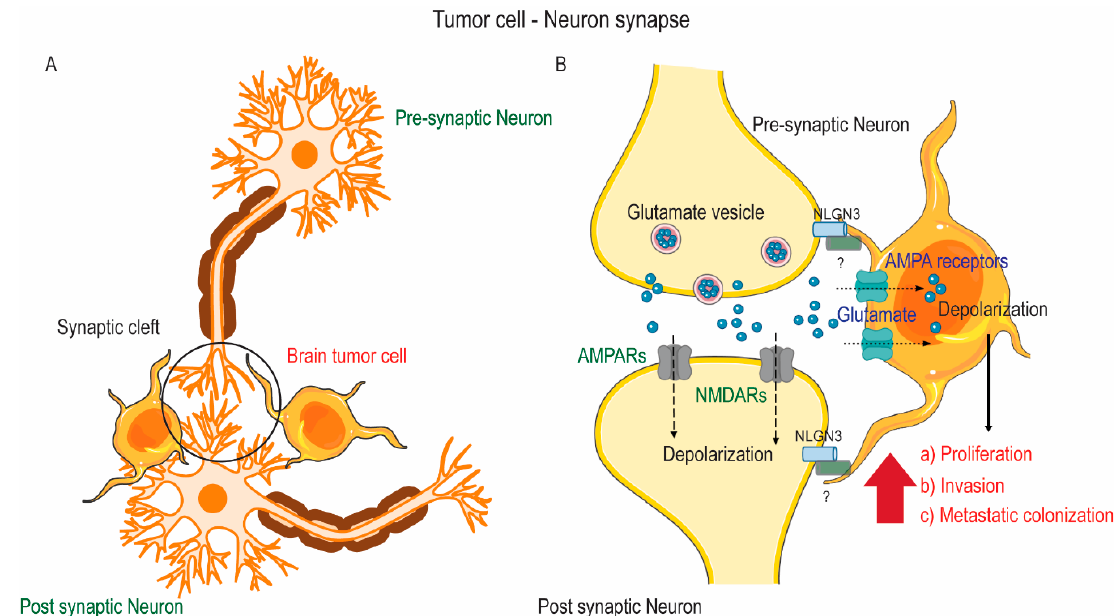
Figure 2. Glioma—Neuron crosstalk. ( A ) Glioma cells form synaptic connections with neurons at glutamatergic synapses. ( B ) Brain tumor cells upregulate glutamate receptor (including AMPA family of receptors) and post-synaptic structural genes (including neuroligin-3) to establish synaptic connections. Electrochemical stimulation of neurons results in release of glutamate in the synaptic cleft, which rapidly depolarizes glioma. This drives an influx of Ca 2+ ions, which promotes tumor cell proliferation and increases invasiveness and metastatic colonization of glioma cells. Abbreviations: AMPA, α -amino-3-hydroxy-5methyl-4-isoxazole propionic acid; NMDA, N-methyl-D-aspartate; NLGN-3, Neuroligin-3.